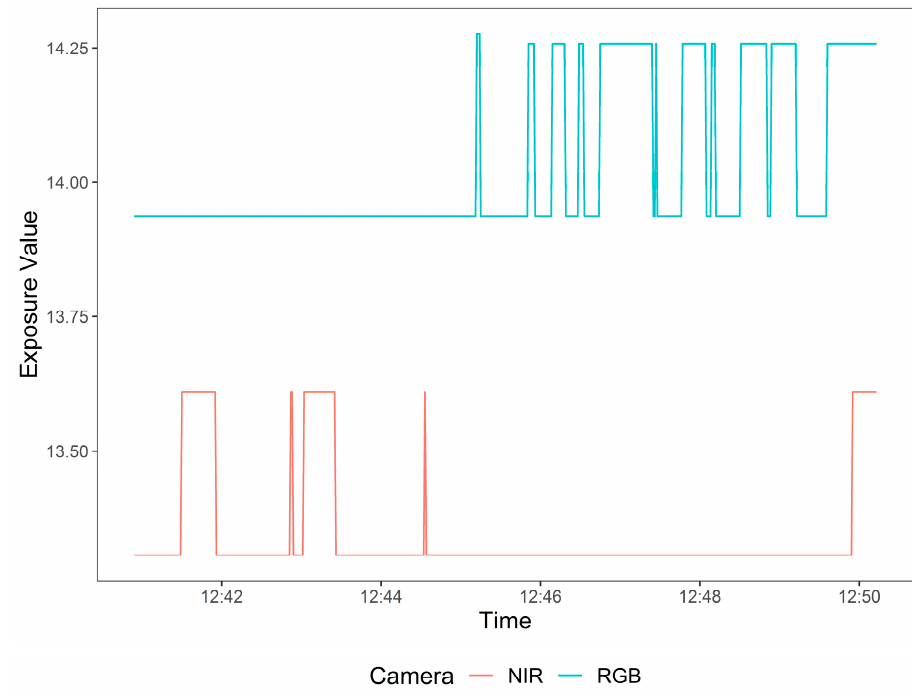
Figure 10. Exposure value for the RGB and NIR cameras over the duration of a flight showing the cameras adjusting exposure independently. Data is from the flight on 21 June 2017.